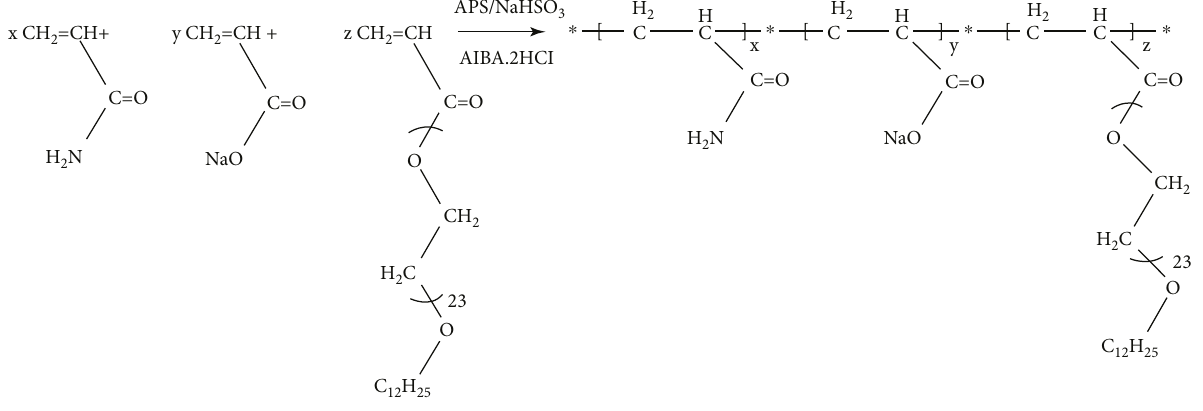
Figure 1: Equations of polymer